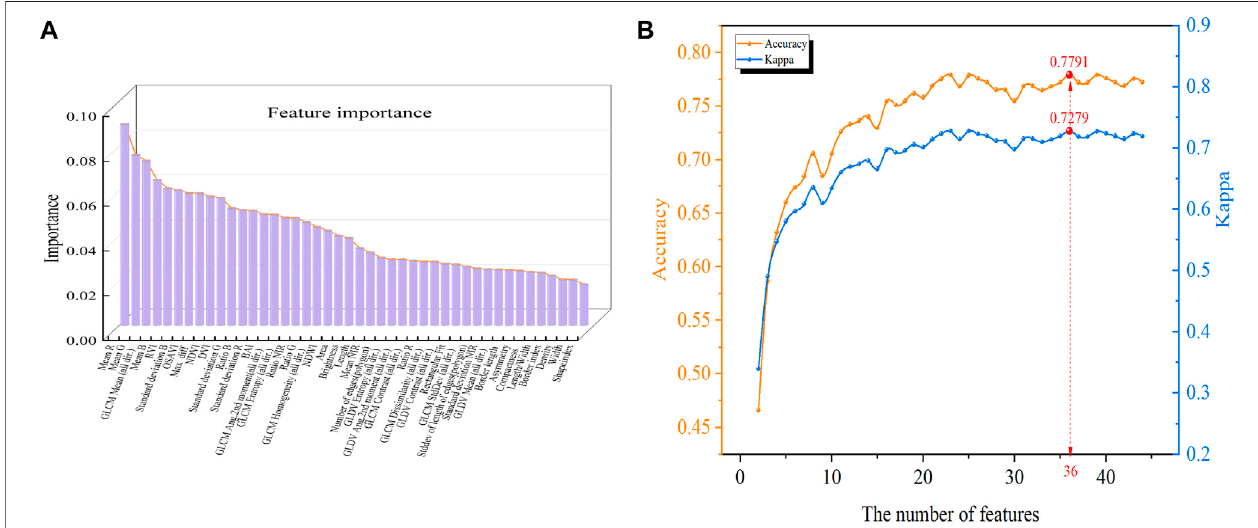
FIGURE 9 | (A) Order of the importance of the initial features in the QuickBird image and (B) the relationship between the prediction accuracy and the number of features in the QuickBird image.